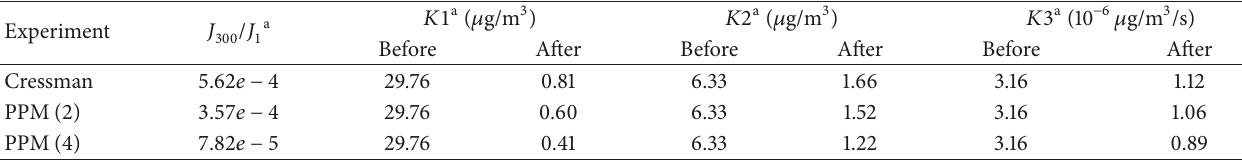
Table 3: The MAEs statistics before and after assimilation, with 49 observation points.